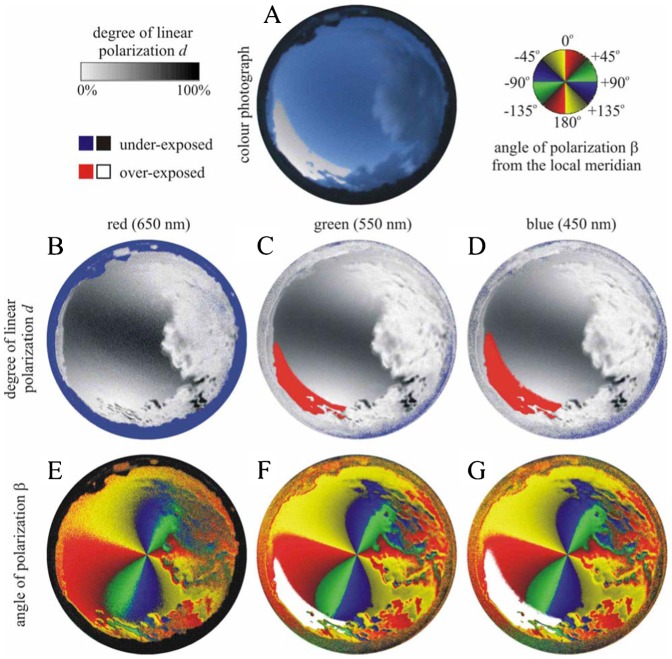
As Fig. 4 for the partially cloudy sky no. 454